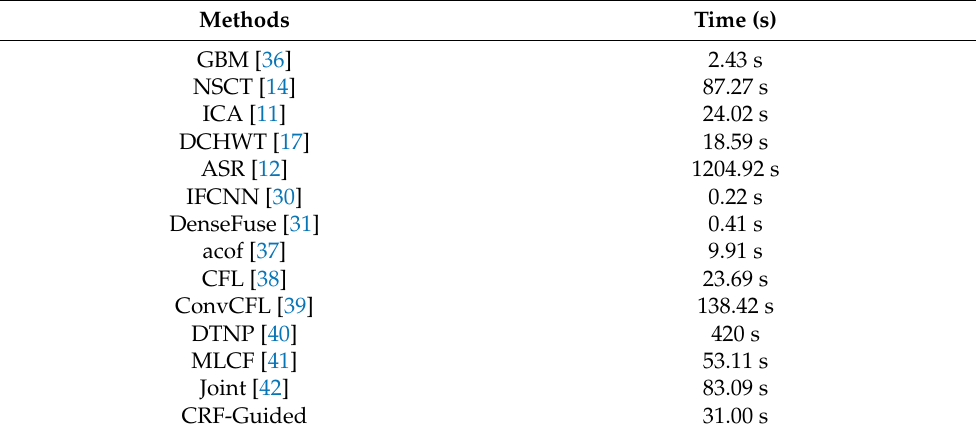
Table 3. Average running time of compared methods for input image pairs of size [ 520 × 520 ]